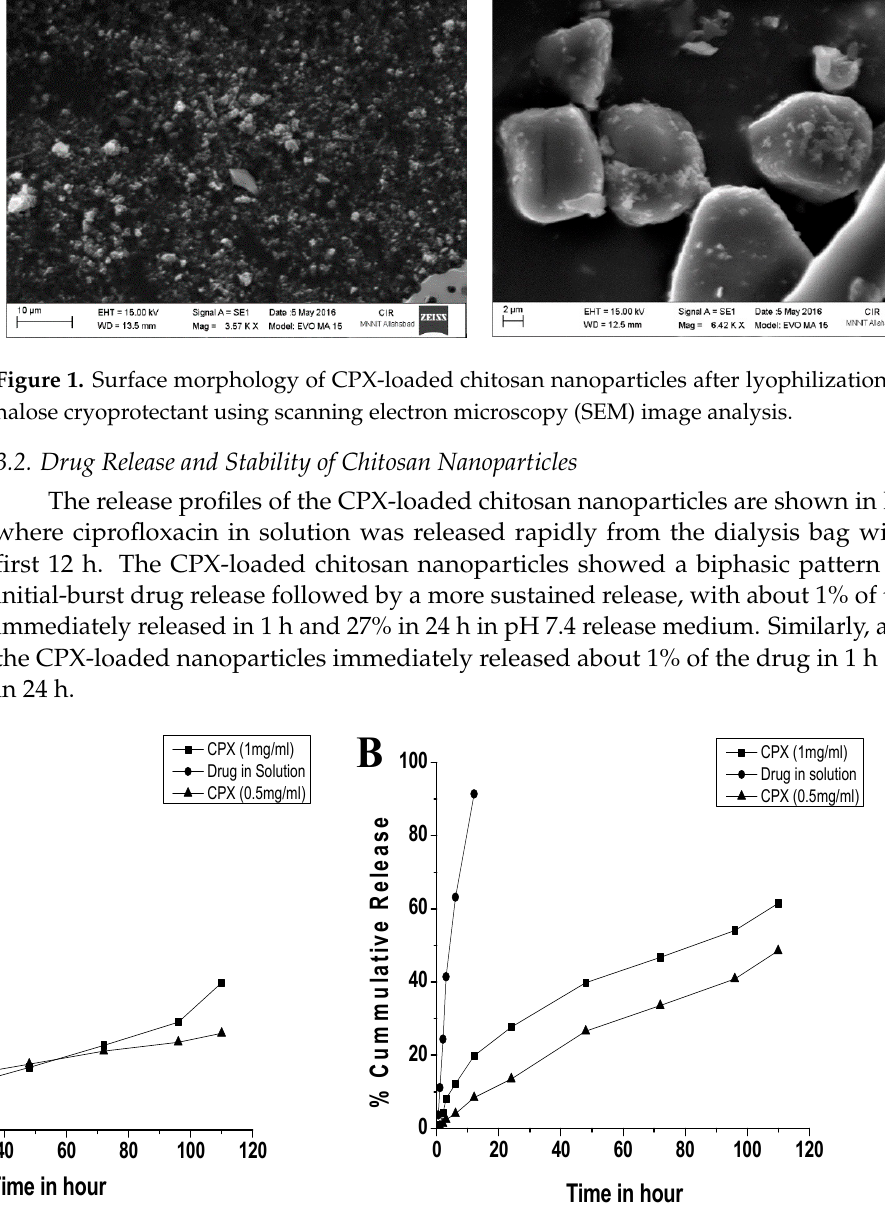
Figure 2. In vitro drug release study of ciprofloxacin hydrochloride-loaded chitosan nanoparticles in ( A ) PBS buffer at pH 5.2 and ( B ) PBS buffer at pH 7.4.